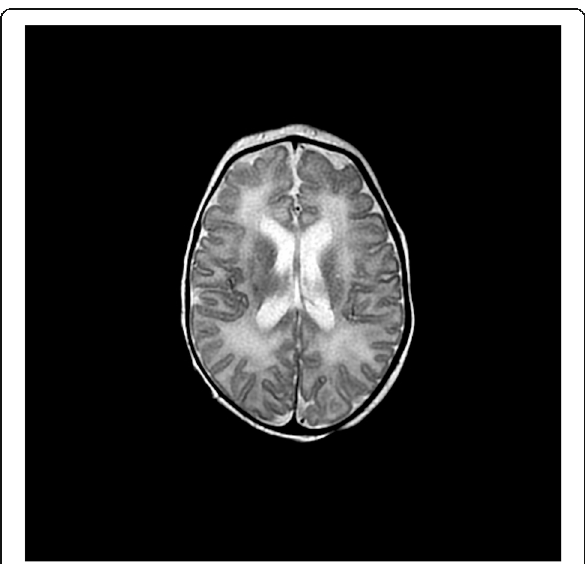
Fig. 5 MRI image of our patient showing increased signal in cortical white